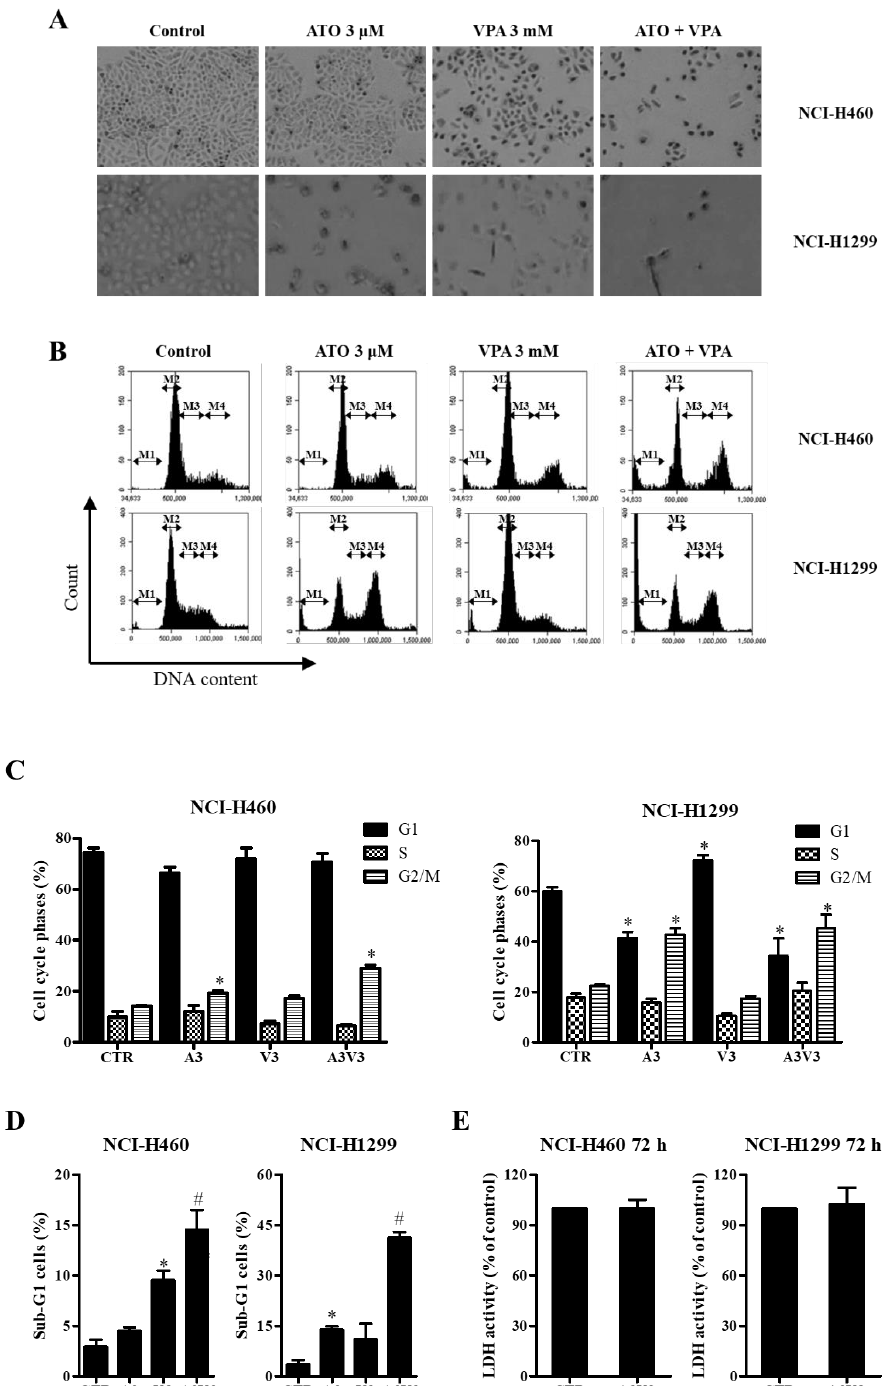
Figure 2. E ff ects of ATO and VPA alone and in combination on cell morphology and cell cycle distributions. Exponentially growing NCI-H460 and NCI-H1299 cells were treated with 3 µ M ATO and / or 3 mM VPA for 72 h. ( A ): Cell morphology changes were captured by an inverted microscope (40 × ). ( B ): Cell cycle distributions were measured by BD Accuri C6 flow cytometry (M1 regions show sub-G1 cells, M2: G1 phase, M3: S phase, M4: G2 / M phase). ( C ): Percentages of G1, S, and G2 / M phases in M2, M3, and M4 regions of Figure 2B. ( D ): Percentages of sub-G1 cells in M1 regions of Figure 2B. ( E ): LDH release in NCI-H460 and NCI-H1299 cells co-treated with ATO / VPA. * p < 0.05 as compared with the control group. # p < 0.05 as compared with cells treated with ATO or VPA. ( n =